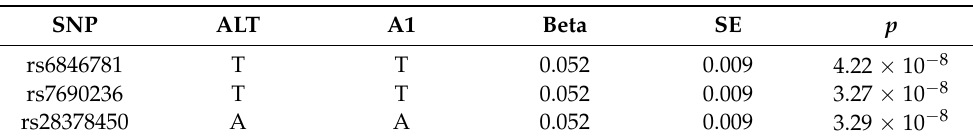
Note: SNP = single nucleotide polymorphism; ALT = alternate alleles; A1 = tested allele; SE = standard error; p = p -value.